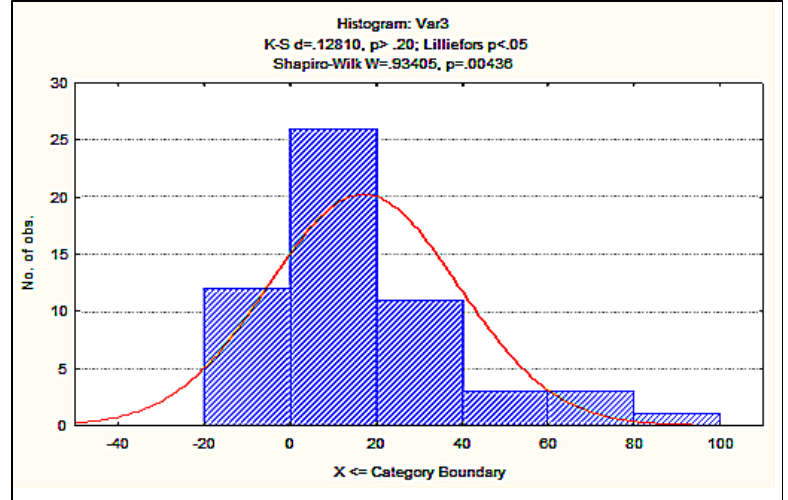
Fig. 2: Testing the hypothesis of normal distribution of combined sample